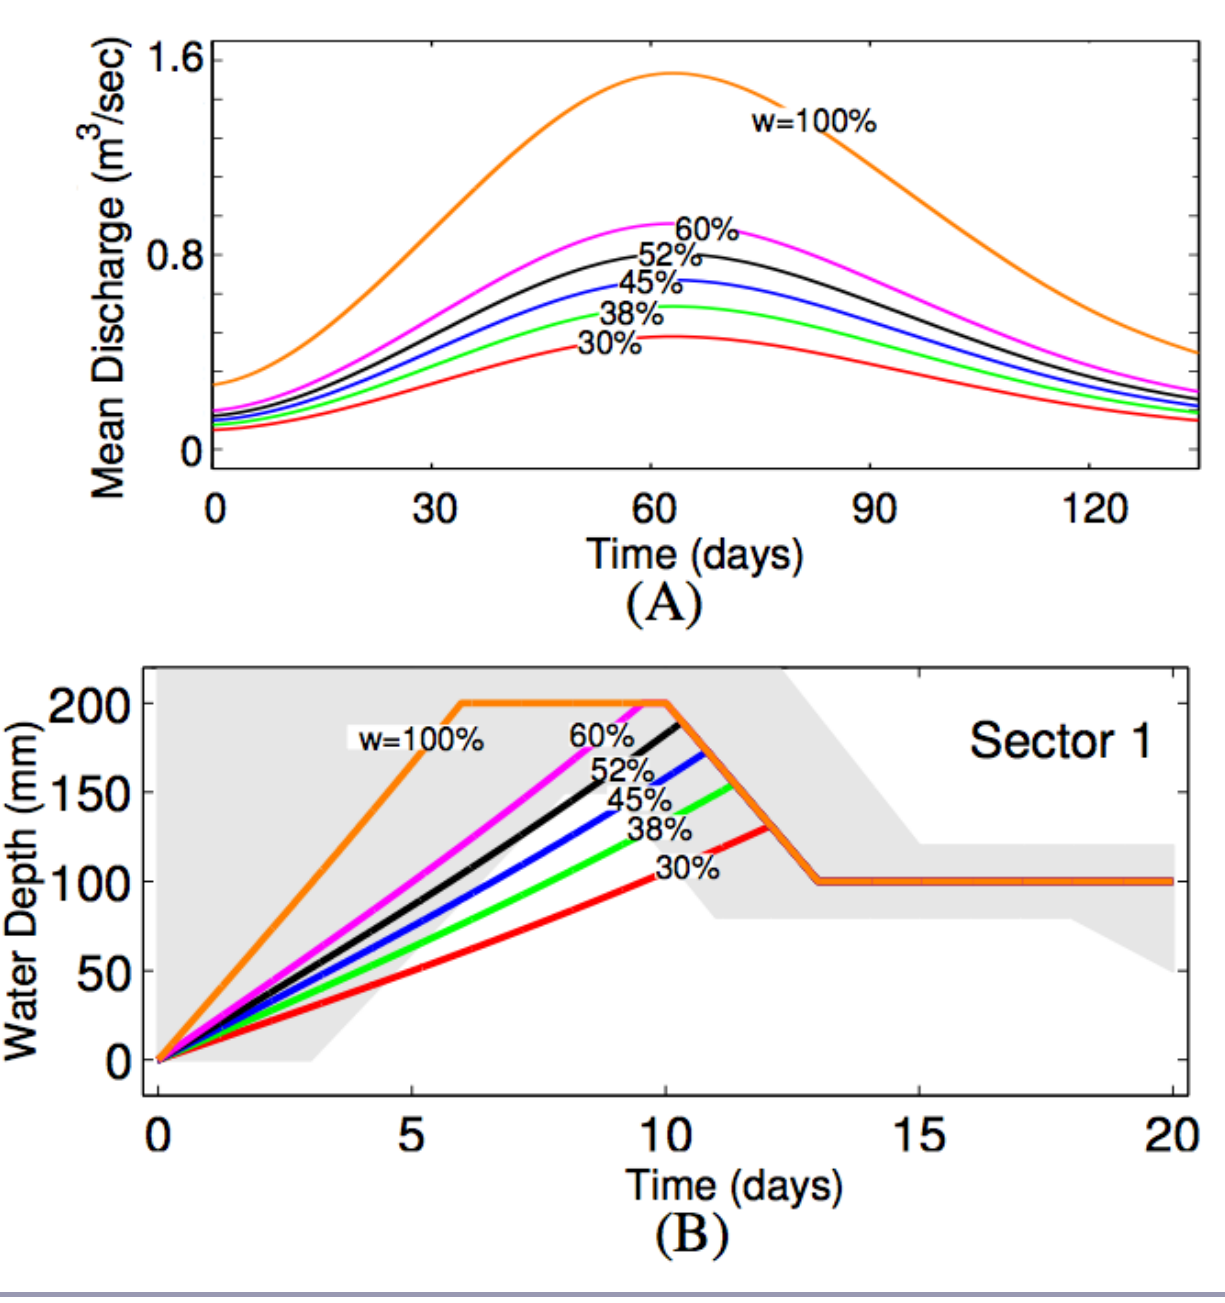
Fig. 6 . (A): River discharge volume scenarios. (B): Associated irrigation water supply profiles (color coded) superimposed on desired supply level range (gray shaded